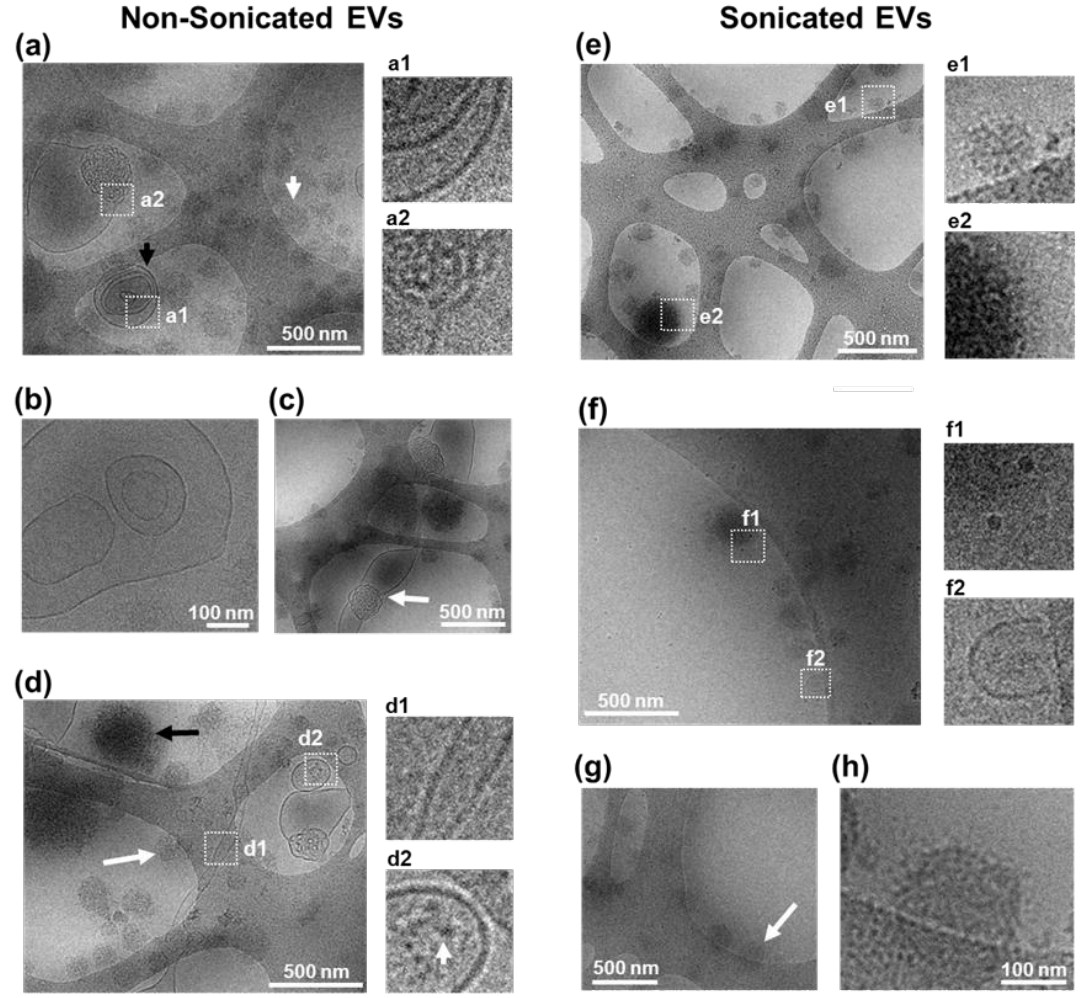
Figure 3. Cryo-TEM characterisation of EVs. ( a – d ) Characterisation of non-sonicated EVs. ( a ) Example of multiple EVs with (black arrow) or without (white arrow) a clear membrane border. Inserts show magnified area of EV containing multiple concentric EVs ( a1 ), and of EV with membrane disorganisation ( a2 ). ( b ) View of a multi-vesicular non-concentric EV. ( c ) Image from an EV structure >500 nm with disorganised shape and membrane (white arrow). ( d ) Image showing a tubular EV-structure with defined border ( d1 ) and an EV with electron-dense features inside ( d2 ). Arrow in ( d2 ) magnified view shows features with electron contrast within an EV. Arrows in ( d ) show round structures with no clear membrane either with high electron contrast (black arrow) or low electron contrast (white arrow). ( e – h ) Characterisation of sonicated EVs. ( e ) Image showing multiple EVs without a clear membrane border having either low electron contrast ( e1 ) or high electron contrast ( e2 ). ( f ) Image showing multiple 20 nm sized EVs with border-like features ( f1 ) and a portion of an EV structure with clear membrane border ( f2 ). ( g – h ) Example of spherical structures with distorted appearance of membrane border (arrow). ( h ) Higher magnification image of selected object in ( g , arrow) showing punctate low contrast membrane border.